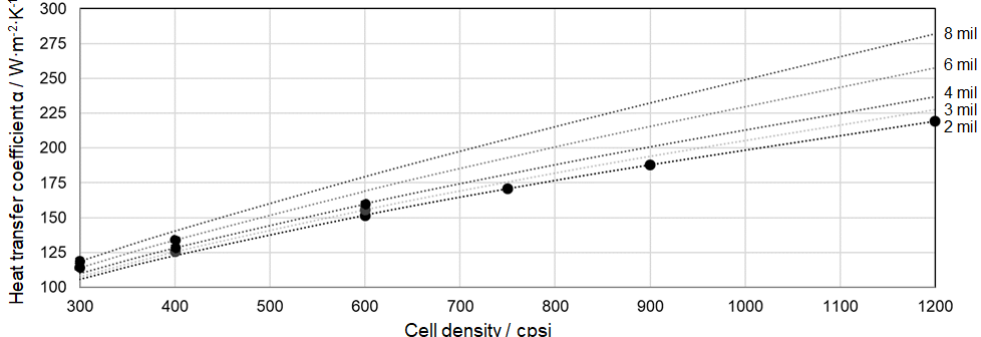
Figure 11. Heat transfer coefficients at a flow rate of 100 kg/h and 523 K.